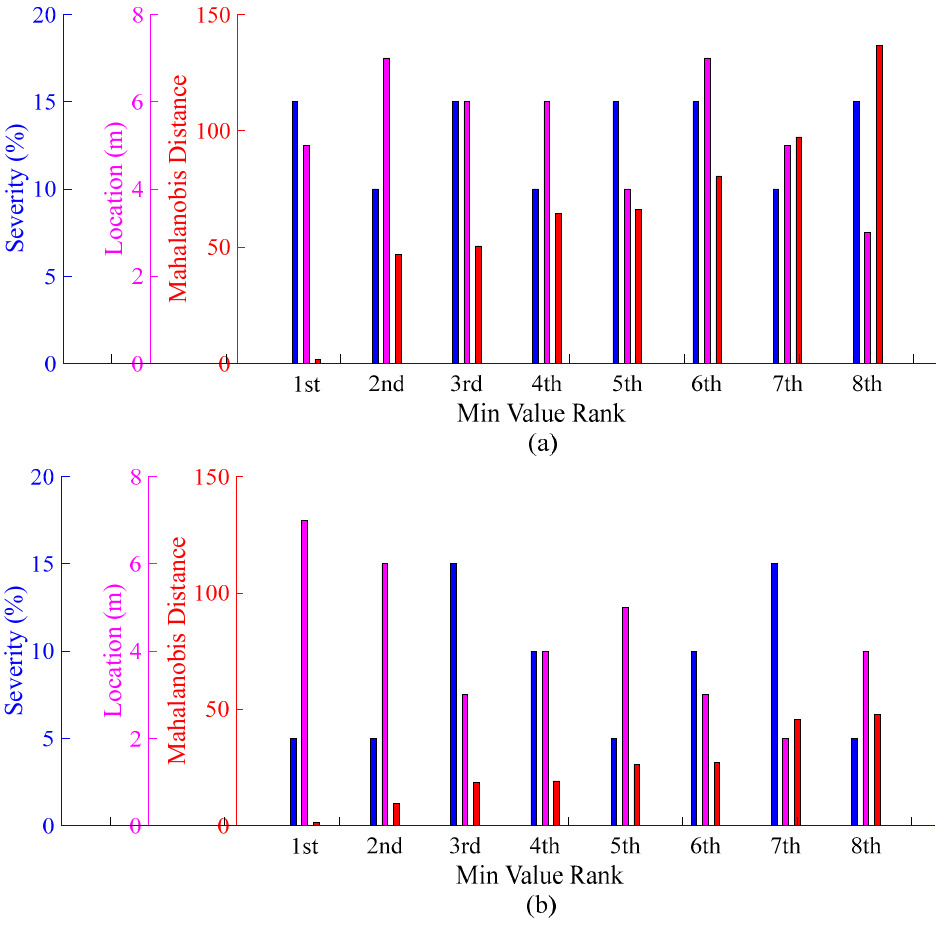
Figure 14. Min value rank of Mahalanobis distance for scenarios: ( a ) 15% crack at 5 m, and ( b ) 5% crack at 7 m.